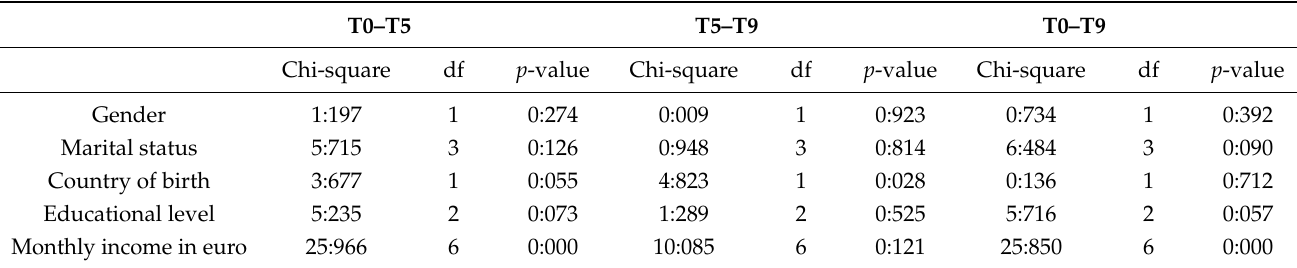
Table 2. p -values for changes in distribution categorical variables.